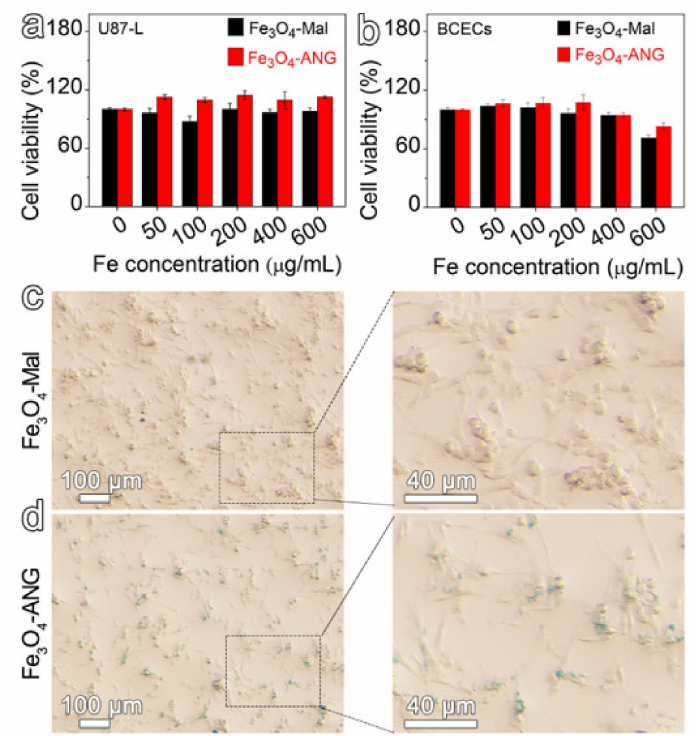
Figure 3. U87-L ( a ) and BCECs ( b ) cells viabilities by CCK-8 assay after incubating with varied concentrations of Fe 3 O 4 -Mal or Fe 3 O 4 -ANG NPs for 24 h. Micrographs of Prussian blue staining of U87-L cells incubated with Fe 3 O 4 -Mal NPs ( c ) or Fe 3 O 4 -ANG NPs ( d ) for 24 h, together the corresponding high magnification